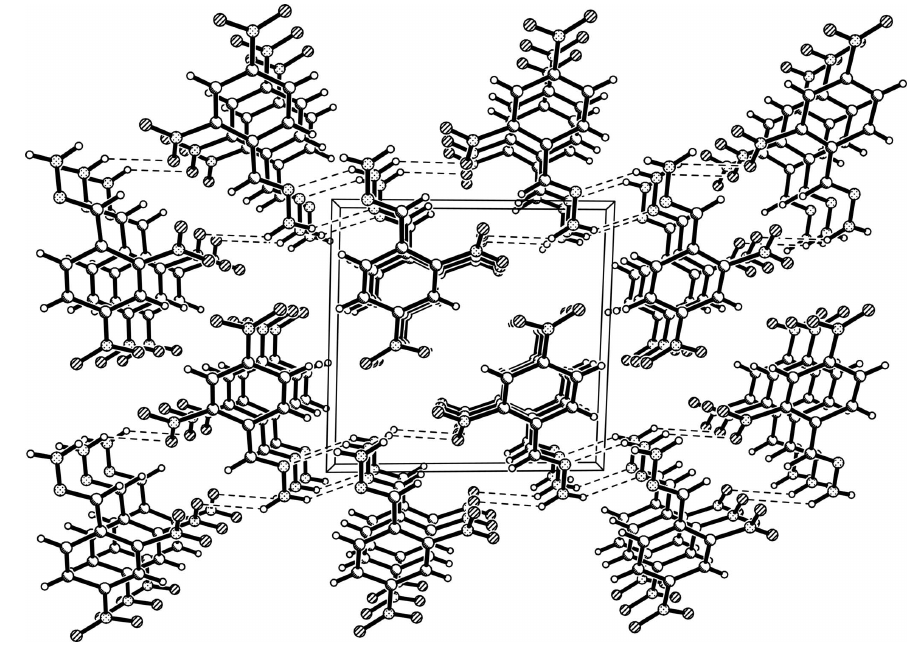
Figure 2 The unit cell packing of the title compound, viewed along the a